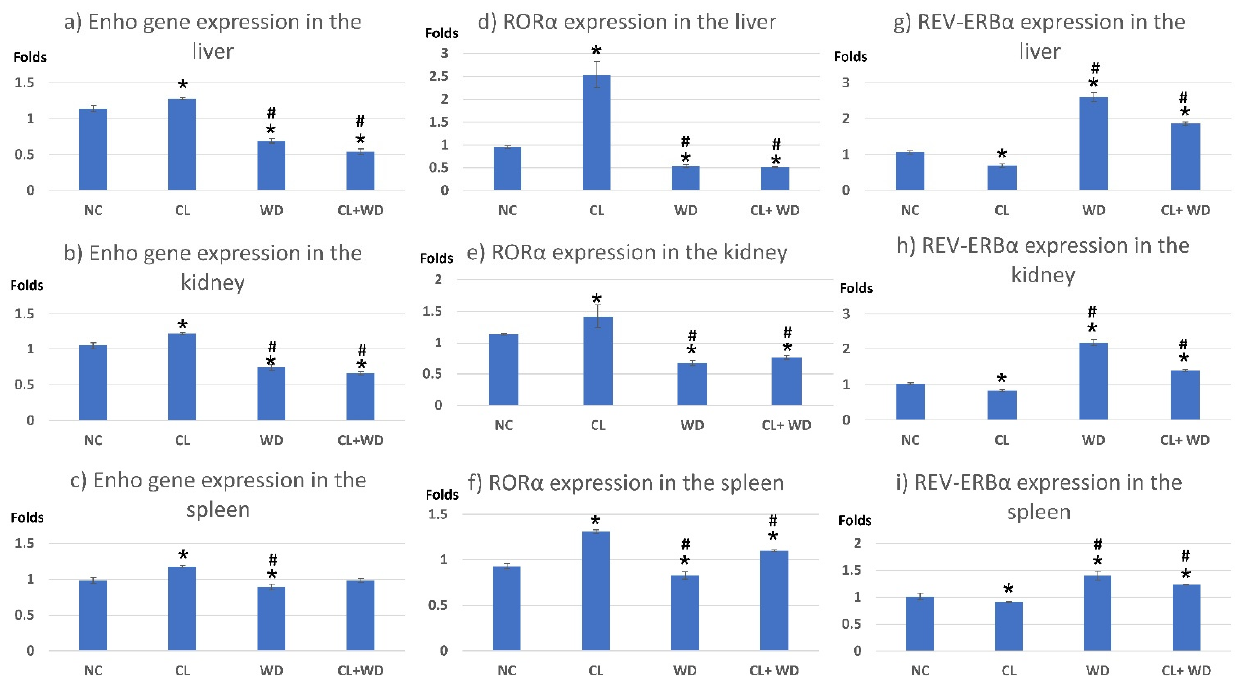
Figure 2. Expression of Enho, ROR α , and Rev-erb- α genes in the peripheral tissues. * significant vs. NC group and # significant vs. CL group. ( a ) Enho gene expression in the liver; ( b ) Enho gene expression in the kidney; ( c ) Enho gene expression in the spleen; ( d ) ROR α expression in the liver; ( e ) ROR α expression in the kidney; ( f ) ROR α expression in the spleen; ( g ) REV-ERB α expression in the liver; ( h ) REV-ERB α expression in the kidney; ( i ) REV-ERB α expression in the spleen. Table 3. Indirect calorimetry parameters of all studied groups ( n = 8/group).